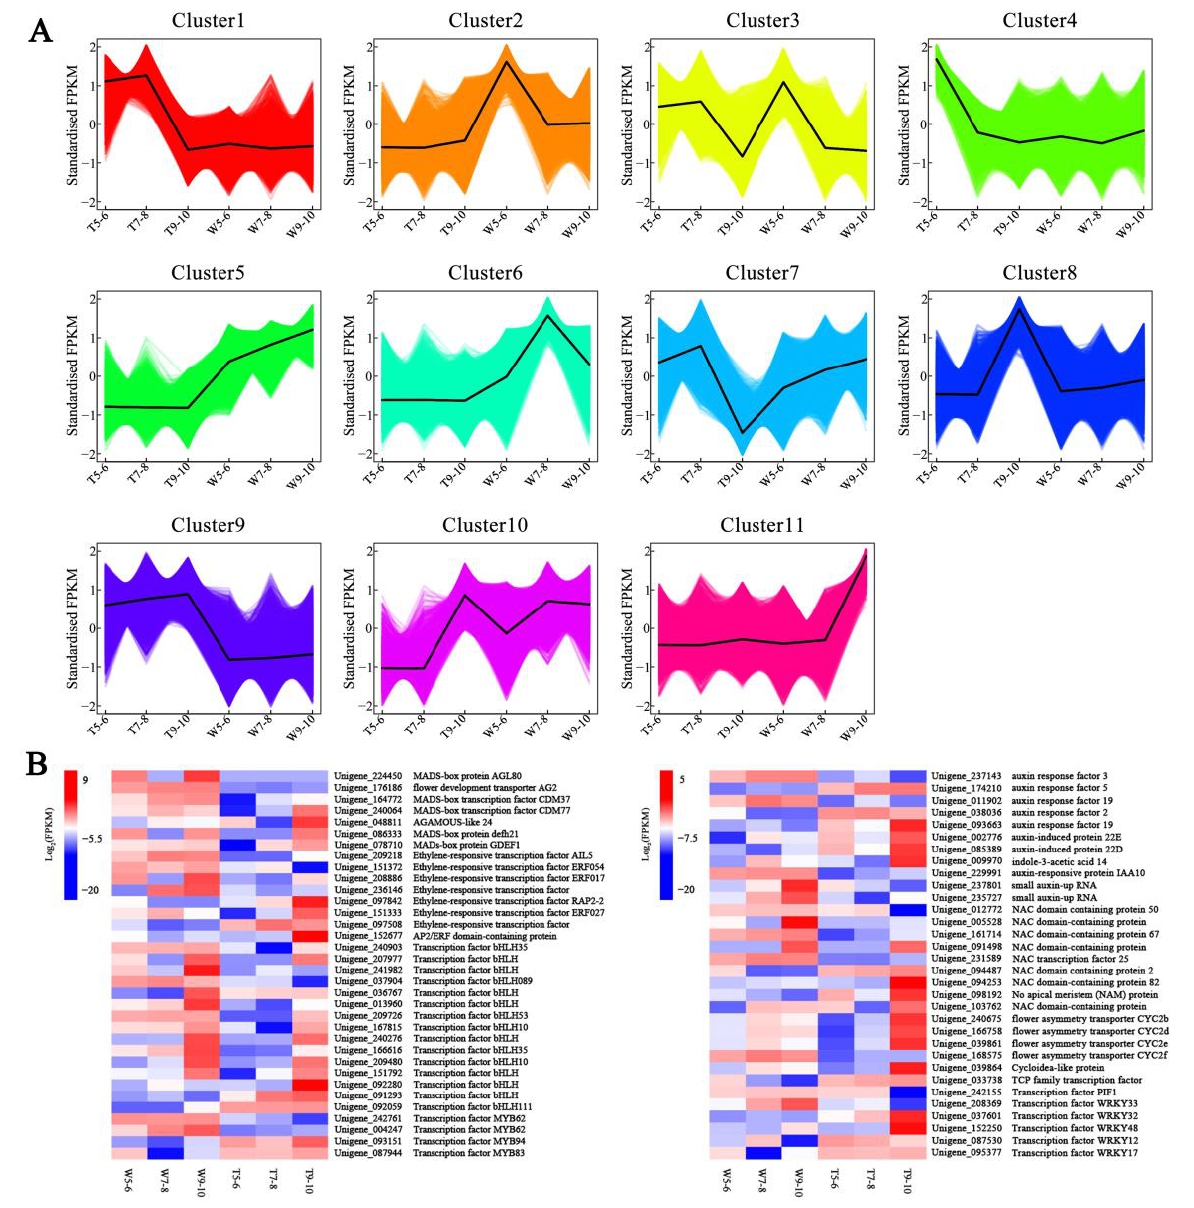
Figure 6. Cluster analysis of all differentially expressed genes (DEGs). ( A ) The eleven clusters of DEGs with different expression patterns. ( B ) Transcription factors detected by K-means cluster analysis.